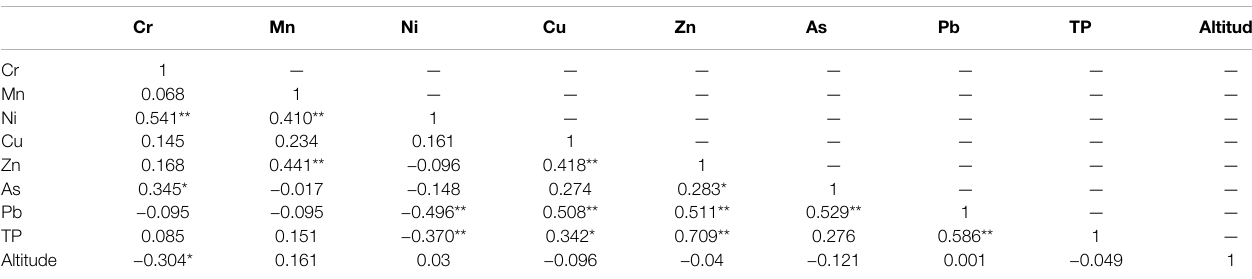
TABLE 8 | Pearson correlation coef fi cient of the concentration of each element. Cr Mn Ni Cu Zn As Pb